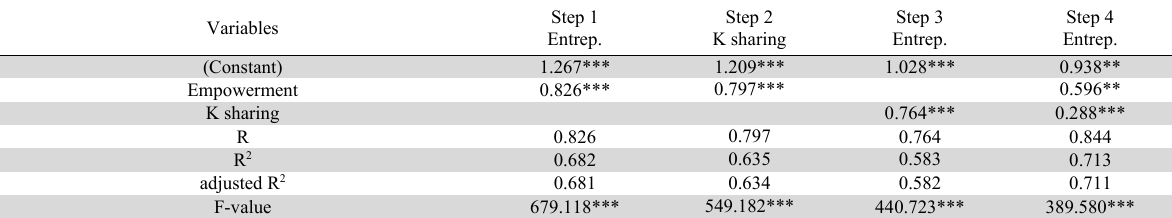
Regression analysis to test hypothesis H2